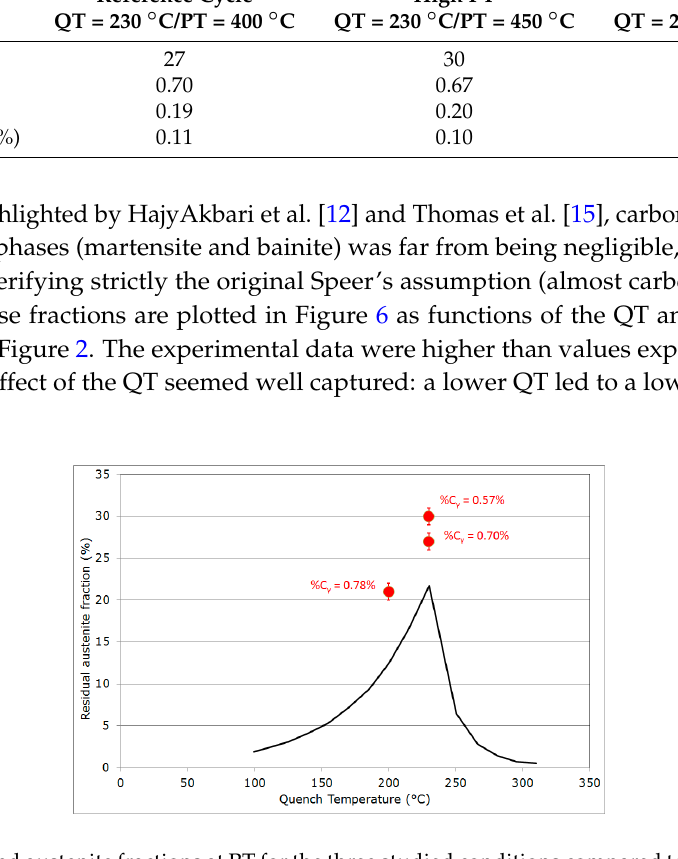
Figure 6. Retained austenite fractions at RT for the three studied conditions compared to the calculations presented in Figure 2. The error bars for phase fraction measurements are fixed to ±1%, as discussed in [23].